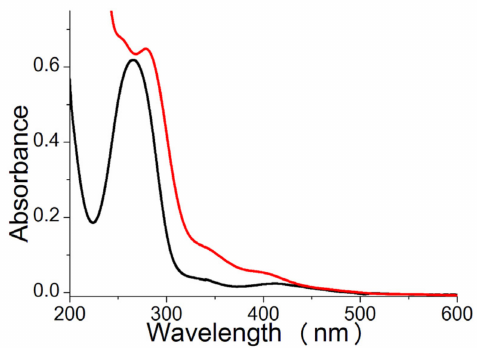
Figure 4. Absorption spectra of the AmFc (black) and PGA-AmFc (red) in deionized